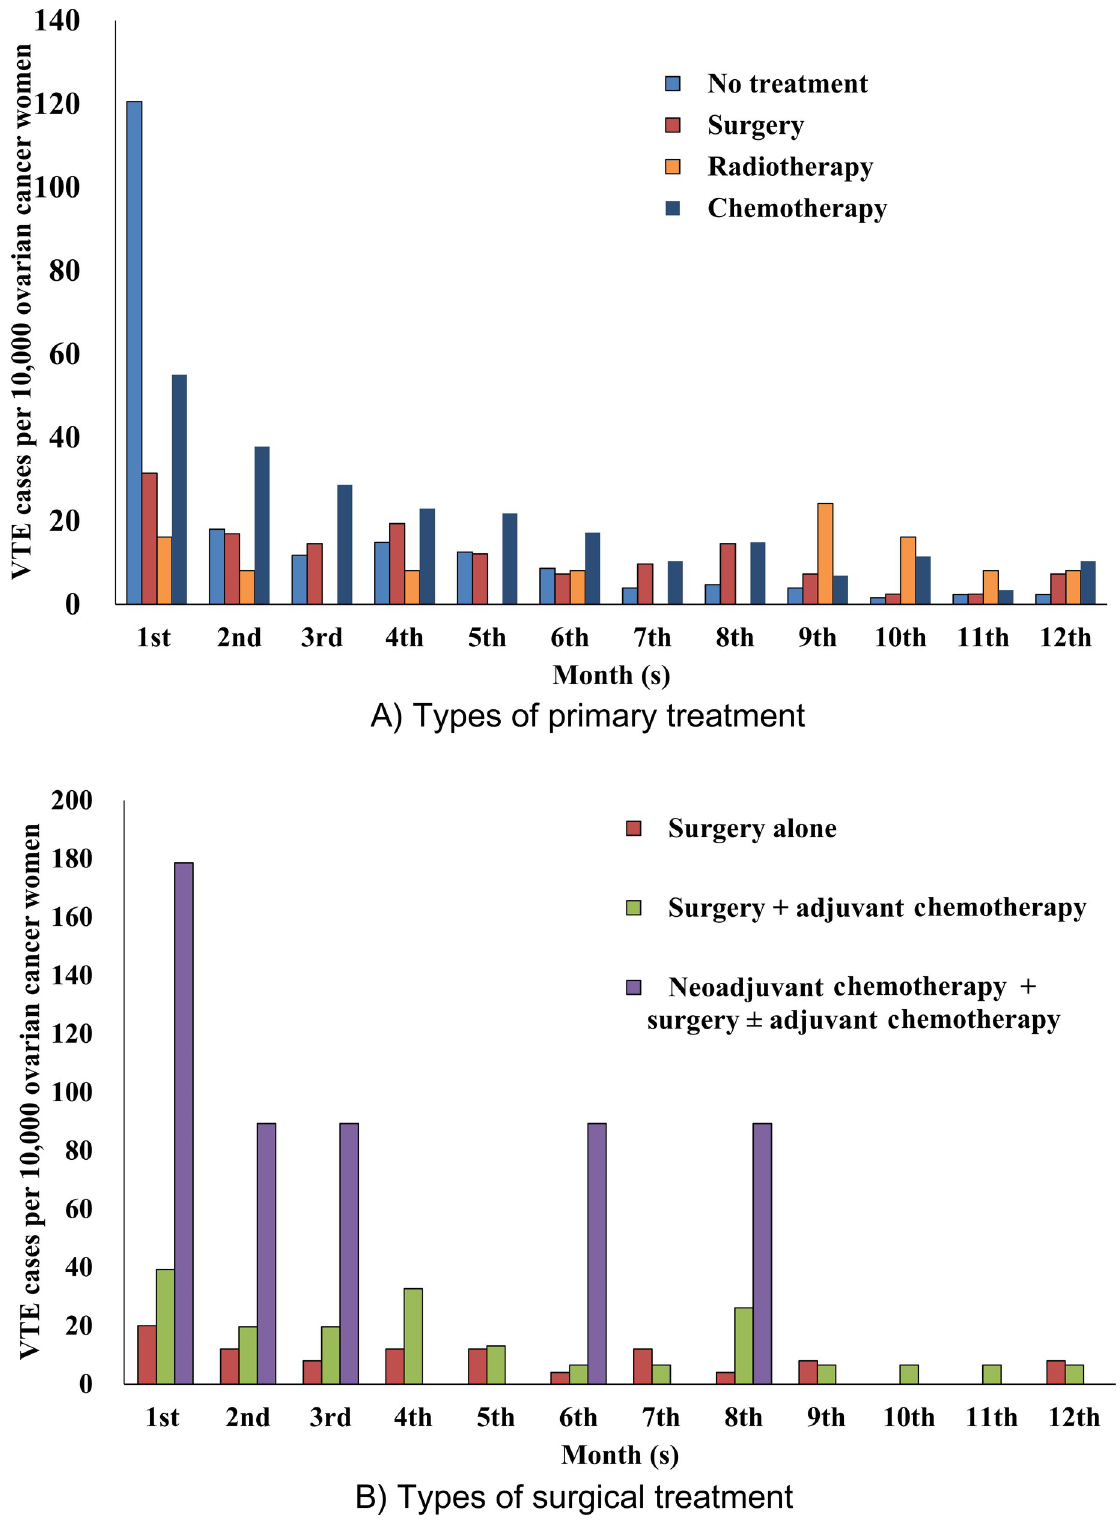
Fig 2. Incidence of VTE for the first 12 months after initiation of primary treatment in women with ovarian cancer (HIRA claims data of 2009–2018). In women who underwent no treatment, incidence of VTE after diagnosis of ovarian cancer was evaluated.